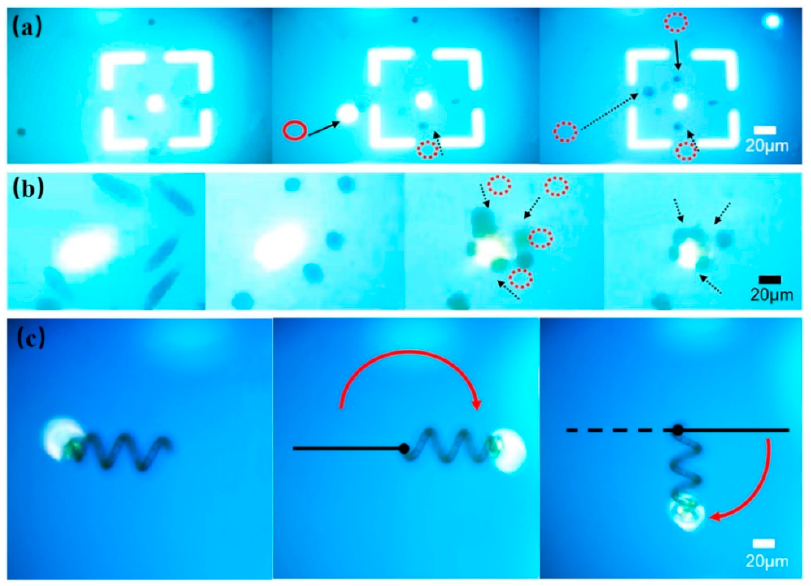
Figure 8. The manipulation of particles with different shapes particles via OET. ( a ) Manipulating macrophages at the square center in the 5% glucose solution; ( b ) Trapping Euglena gracilis in the deionized water; ( c ) Rotating the spirulina in the deionized water.